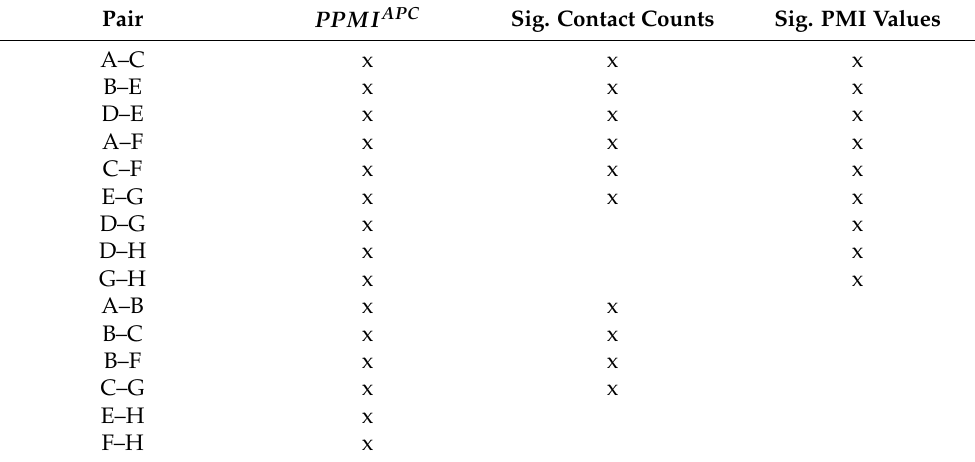
Table 2. Comparison between heifer pairs predicted by our PPMI APC approach with those showing a significant count or PMI values. The significant contact counts or PMI values were determined by creating 1000 samples based on shuffling the pairwise distance data. The contact counts or PMI values were significantly greater compared to those resulting from the random samples. An “x” indicates the presence of an edge. Pair PPMI APC Sig. Contact Counts Sig. PMI Values A–C x x